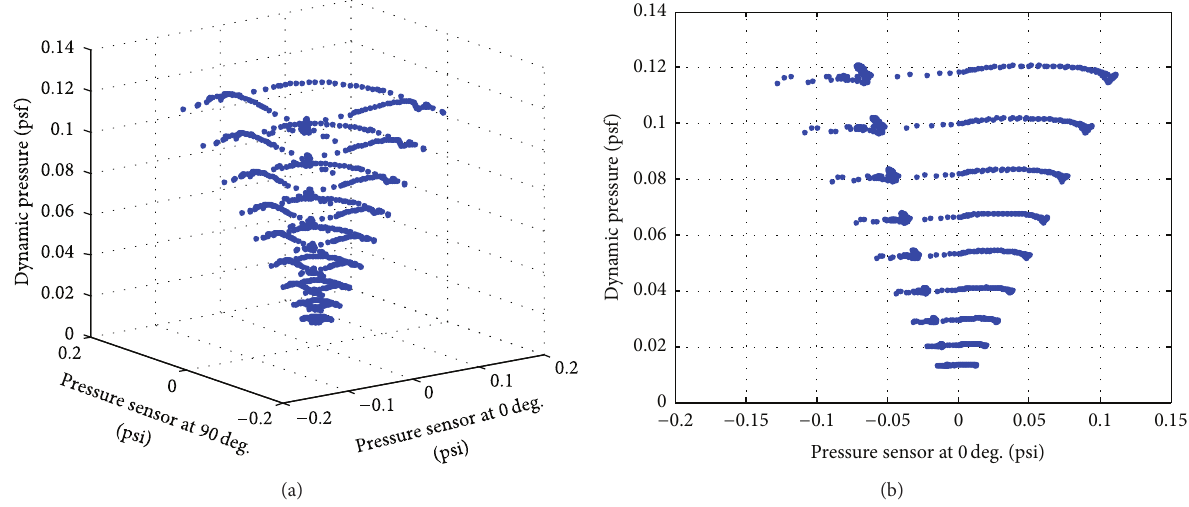
Figure 6: Dynamic pressure hypercone represented as a function of (a) two pressure sensors and (b) one pressure sensor.